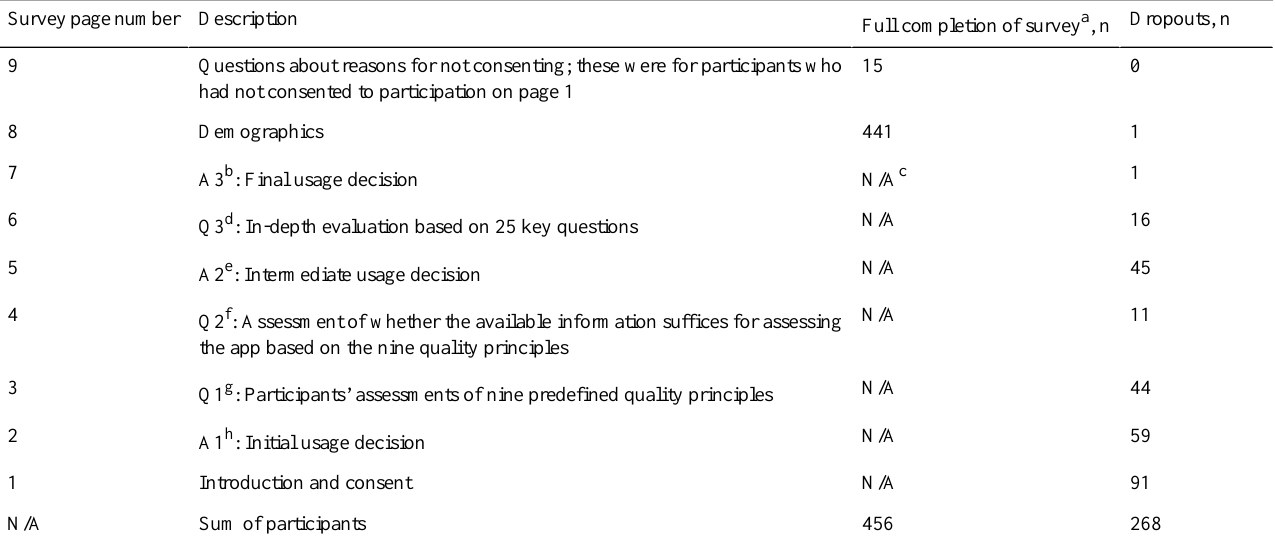
Table 5. Participant dropout at different stages of the survey, from 724 participants who originally started the survey.